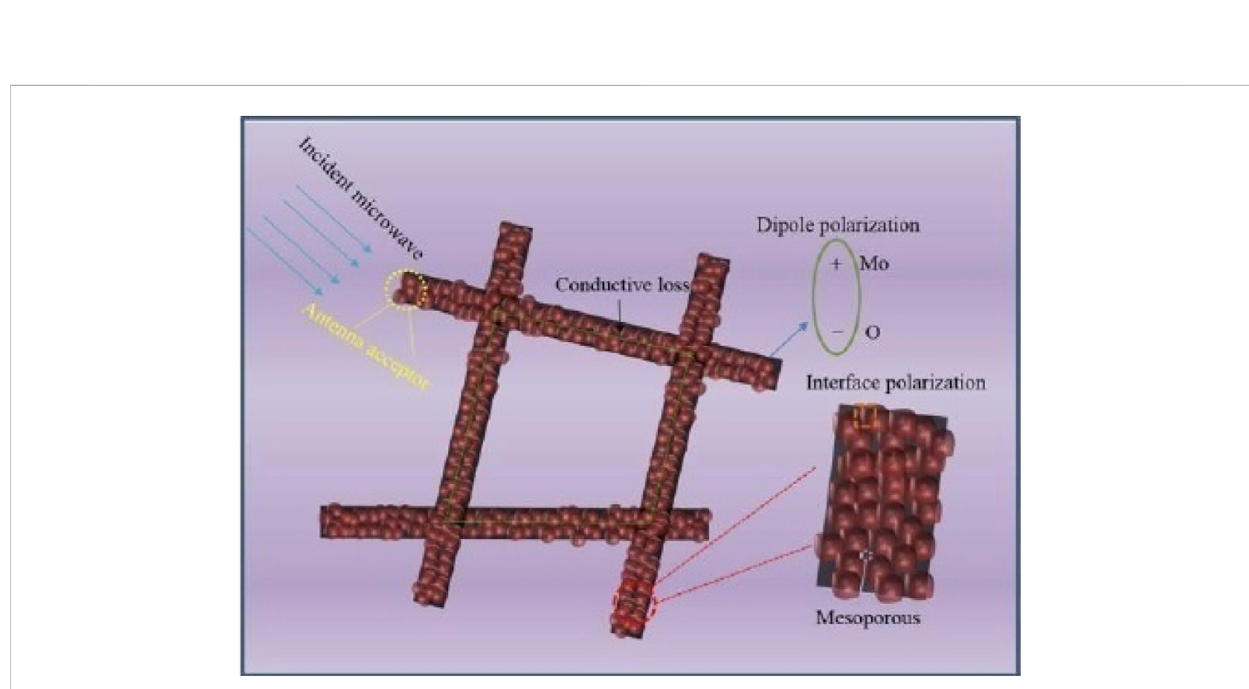
FIGURE 22 Schematic illustration of the microwave-dissipated process in MoO 2 /C nanowires (Cheng et al., 2017b).